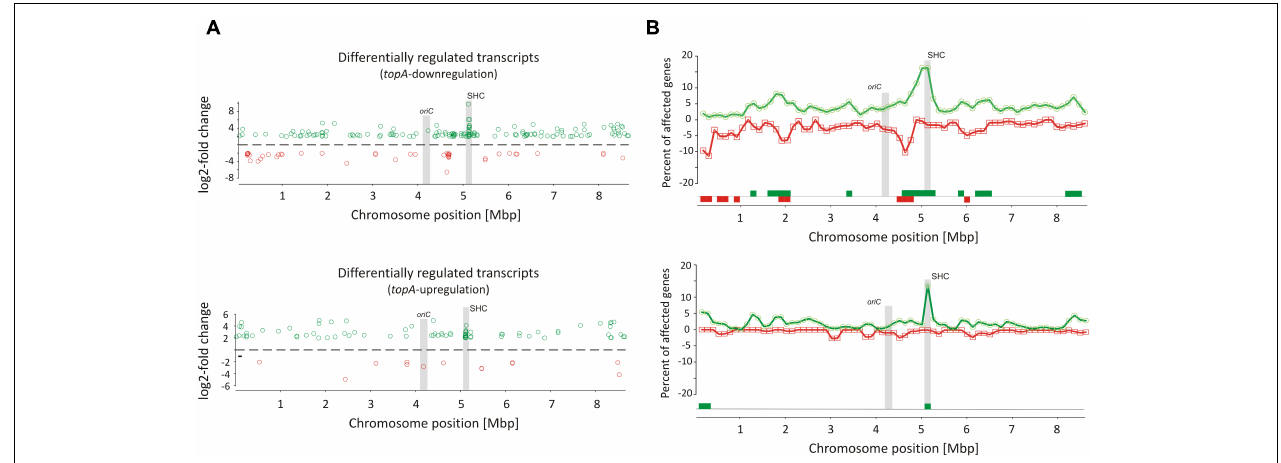
FIGURE 3 | Identification of long-term supercoiling imbalance-sensitive clusters. (A) The chromosomal positions of differentially upregulated (green) and downregulated (red) transcripts identified in the topA -downregulated strain (upper panel) and topA -upregulated strain (lower panel). The positions of the oriC region and the supercoiling-hypersensitive cluster (SHC) are marked in gray. (B) Identification of supercoiling-sensitive clusters. The percent of genes affected by topA downregulation (upper panel) or topA upregulation (lower panel) was calculated in a 250-kbp window and the mid of the window was plotted versus chromosome position. The regions with the percentage of upregulated (green) or downregulated (red) genes higher than 5% (supercoiling-sensitive clusters) are marked at the bottom of the